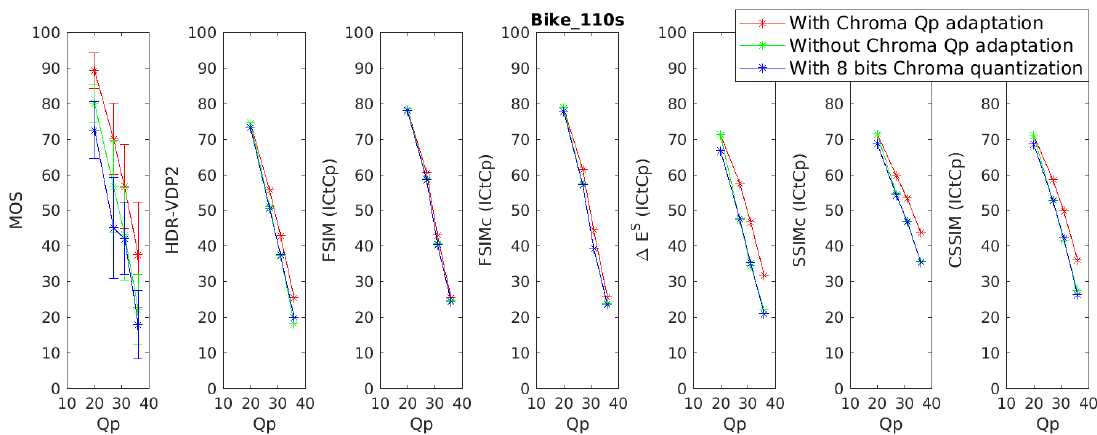
Figure A9. Subjective and objective scores for the image Bike_110s.